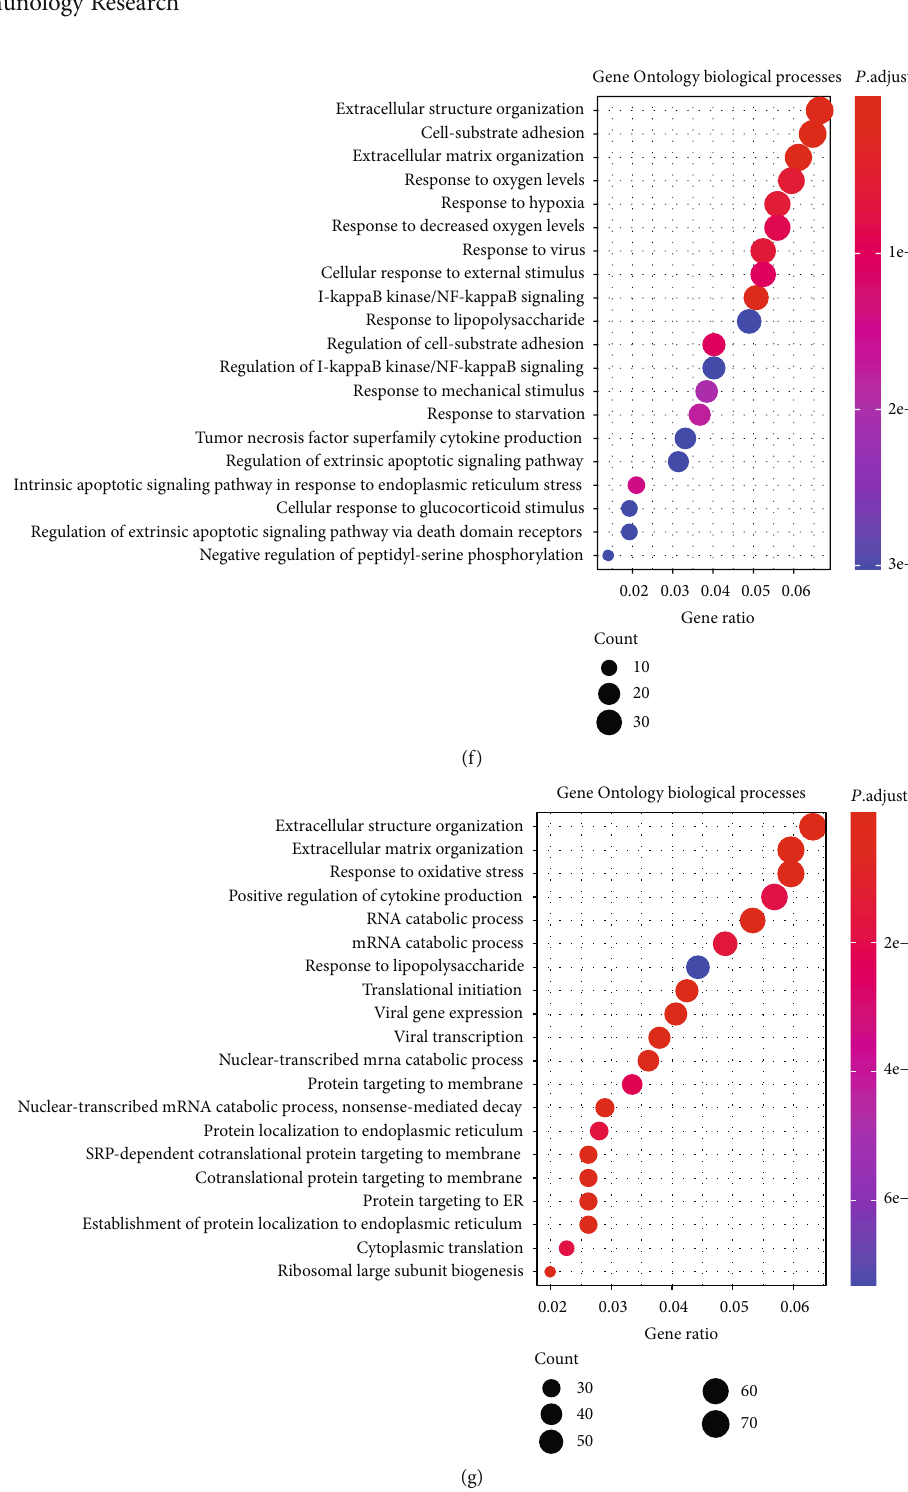
Figure 3: Comparison of DEG of the nonchondrocyte cluster from healthy and OA patients. (a) Volcano plot comparing the gene expression between healthy and OA monocyte clusters. (b) Volcano plot comparing the gene expression between healthy and OA endothelial cell clusters. (c) Volcano plot comparing the gene expression between healthy and OA macrophage clusters. Each plot represents one gene. Threshold of Log fold change has been set as 0.3. (d) Dot plot showing the enrichment of Gene Ontology biological processes in the 2 upregulated monocyte DEG between healthy and OA tissues. (e) Dot plot showing the enrichment of Gene Ontology biological processes in the downregulated monocyte DEG between healthy and OA tissues. (f) Dot plot showing the enrichment of Gene Ontology biological processes in the upregulated endothelial cell DEG between healthy and OA tissues. (g) Dot plot showing the enrichment of Gene Ontology biological processes in the upregulated macrophage DEG between healthy and OA